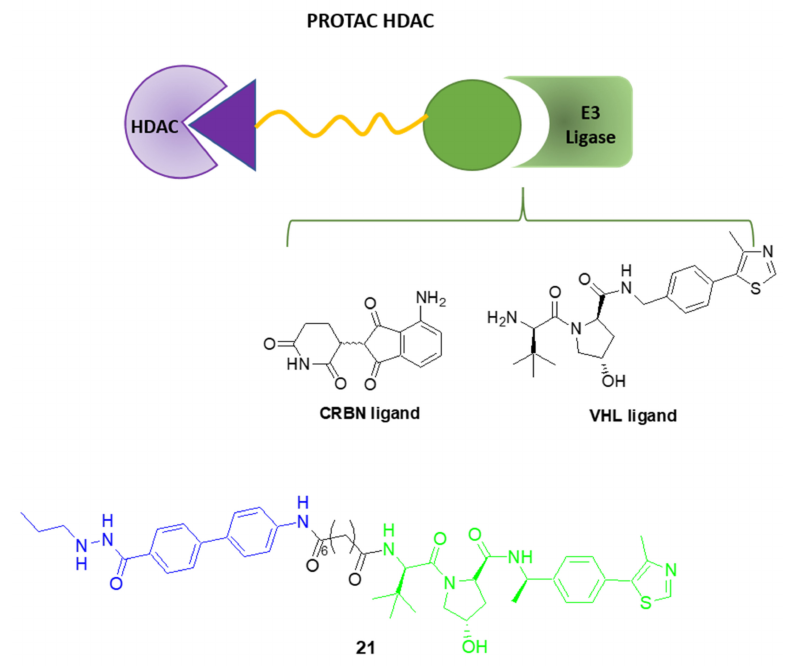
Figure 14. Schematic representation of PROTAC HDAC degraders and chemical structures of compound 21